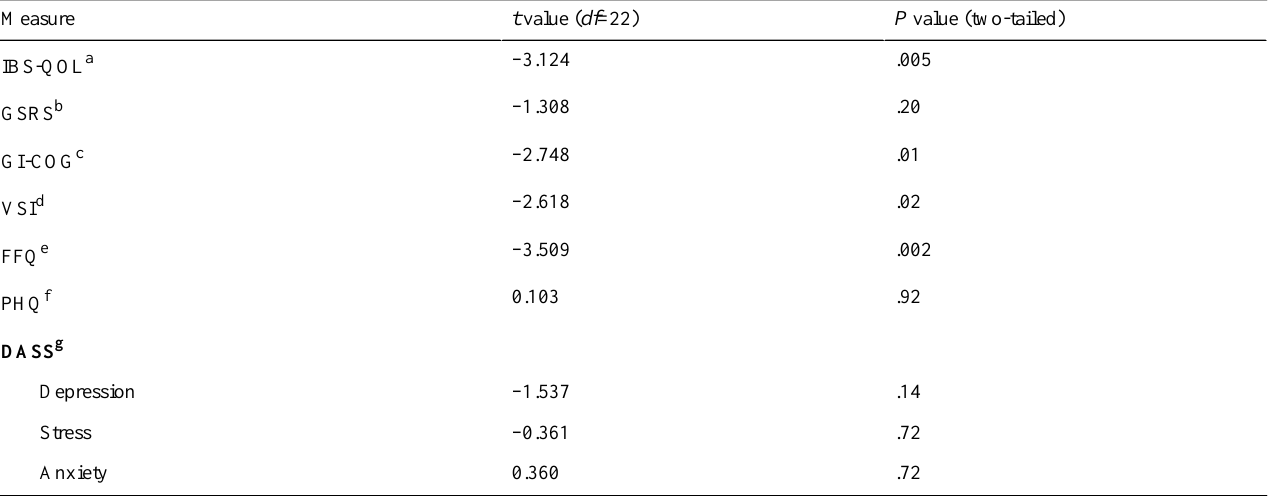
Table 4. Improvement in the waitlist control group after crossover to active treatment.